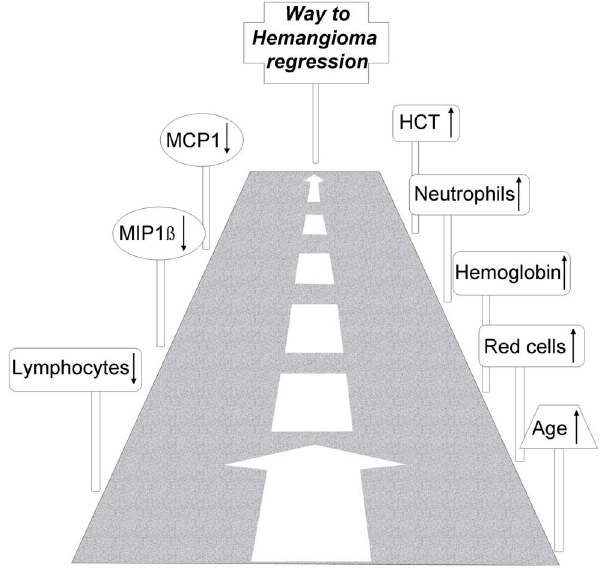
Figure 3. Cartoon summarizing the parameters characterizing IH regression.